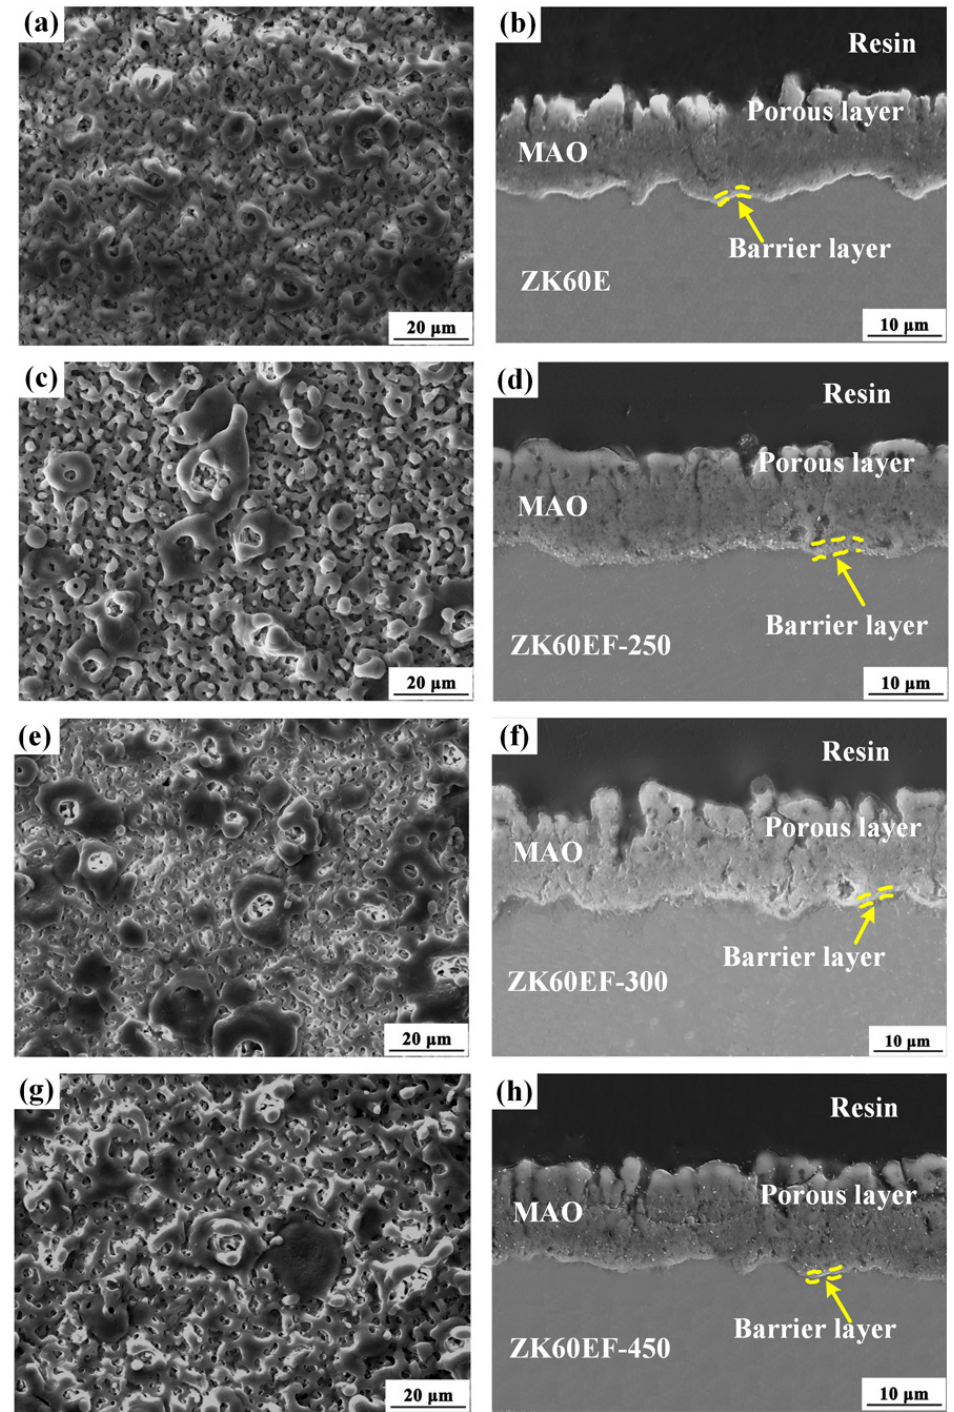
Figure 9. The SEM micrographs of the surface and cross-section of MAO coatings on the ( a , b ) ZK60E, ( c , d ) ZK60EF-250, ( e , f ) ZK60EF-300, and ( g , h ) ZK60EF-450 Mg alloys. ( c , d ) ZK60EF-250, ( e , f ) ZK60EF-300, and ( g , h ) ZK60EF-450 Mg